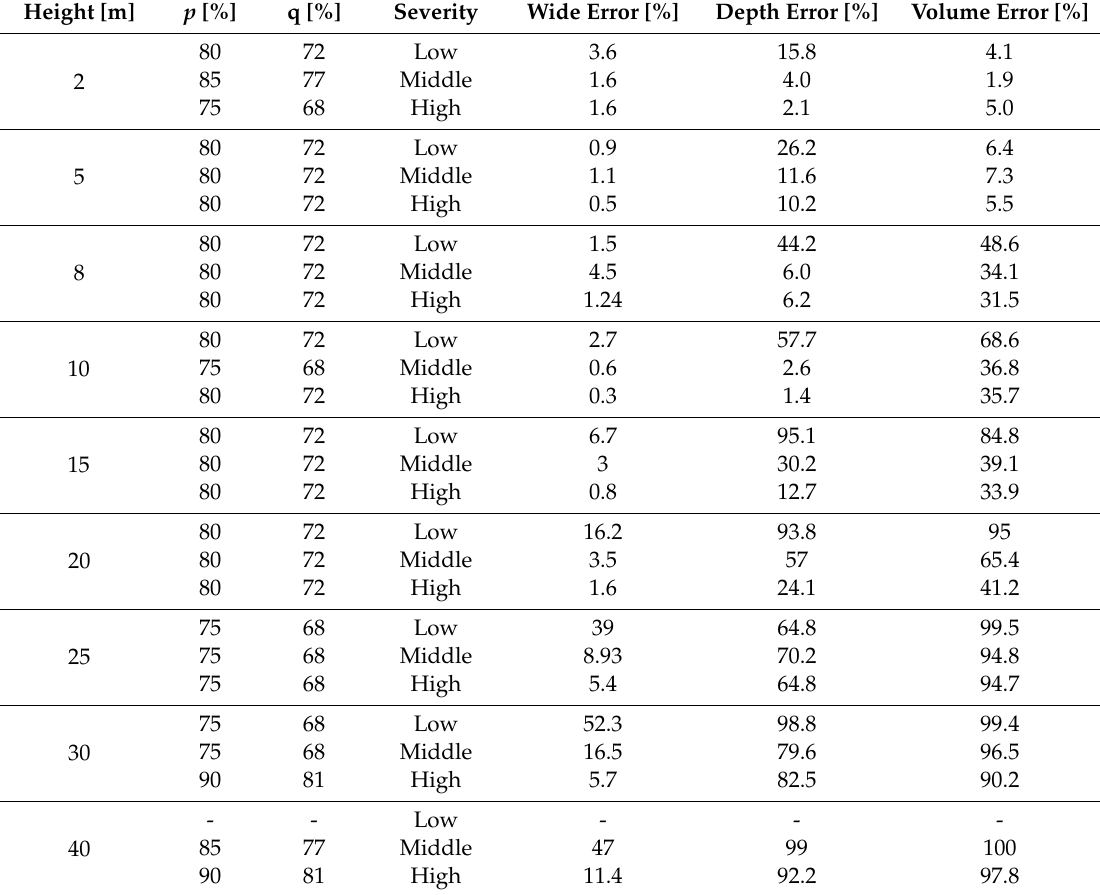
Table 4. Recommended overlap by height associated with severity level of interest to be measured; p is longitudinal overlap and q is transverse